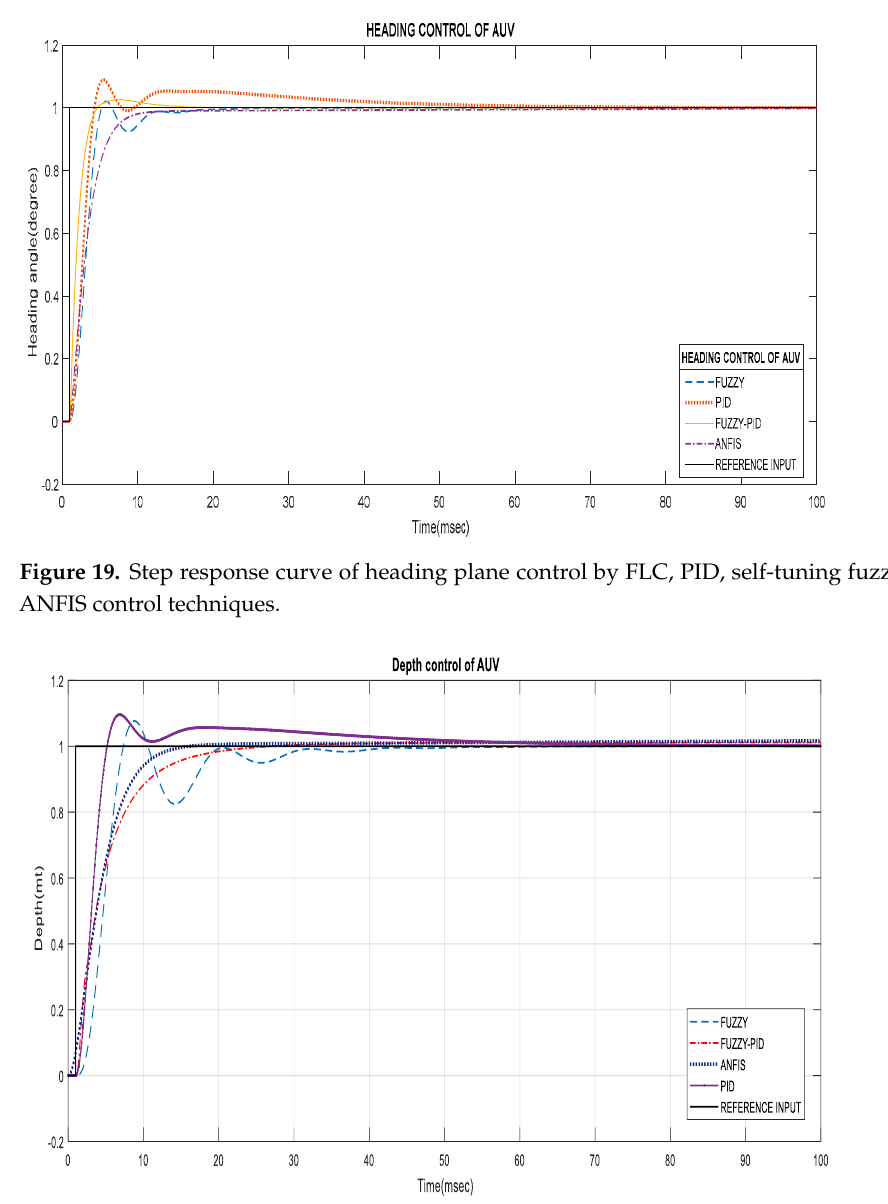
Table 5. Time-response characteristics comparison of heading plane control.